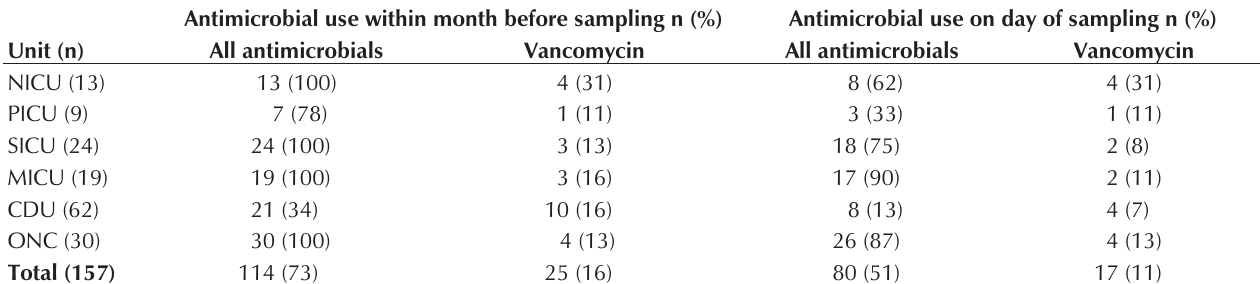
CDU Central dialysis unit; MICU Medical intensive care unit; NICU Neonatal intensive care unit; ONC Leukemia/bone marrow transplant unit; PICU Pediat- ric intensive care unit; SICU Surgical intensive care